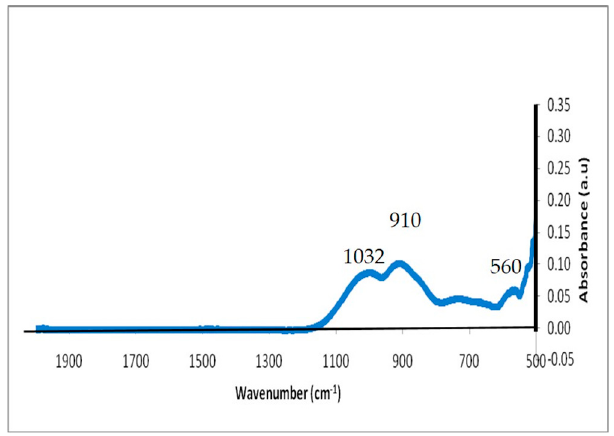
Figure 3. FTIR spectrum of the bioactive glass A1.